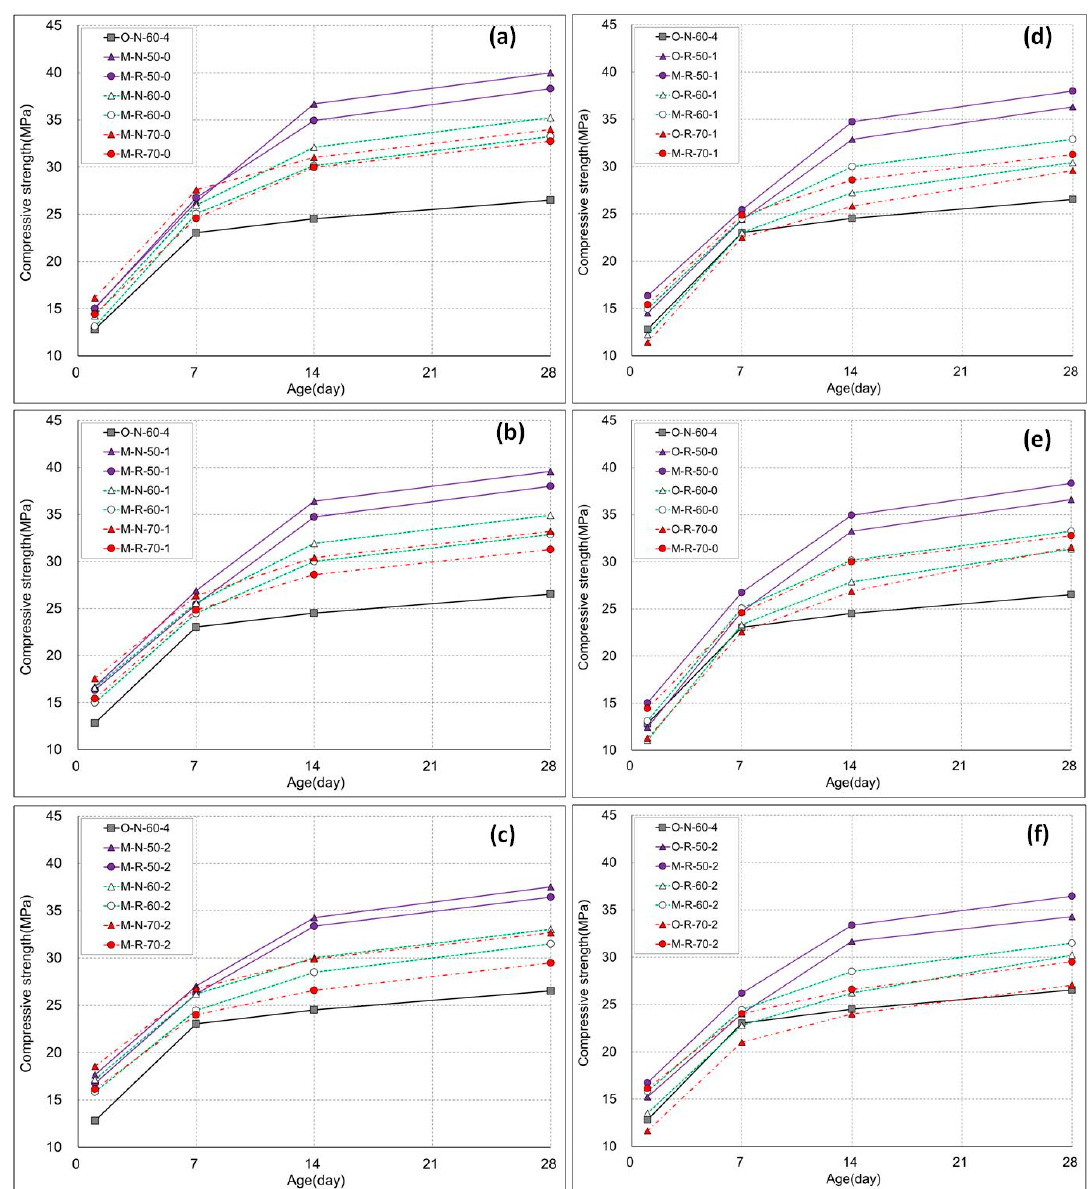
Figure 6. Compressive strength results of all of the mixes, in comparison with the control.